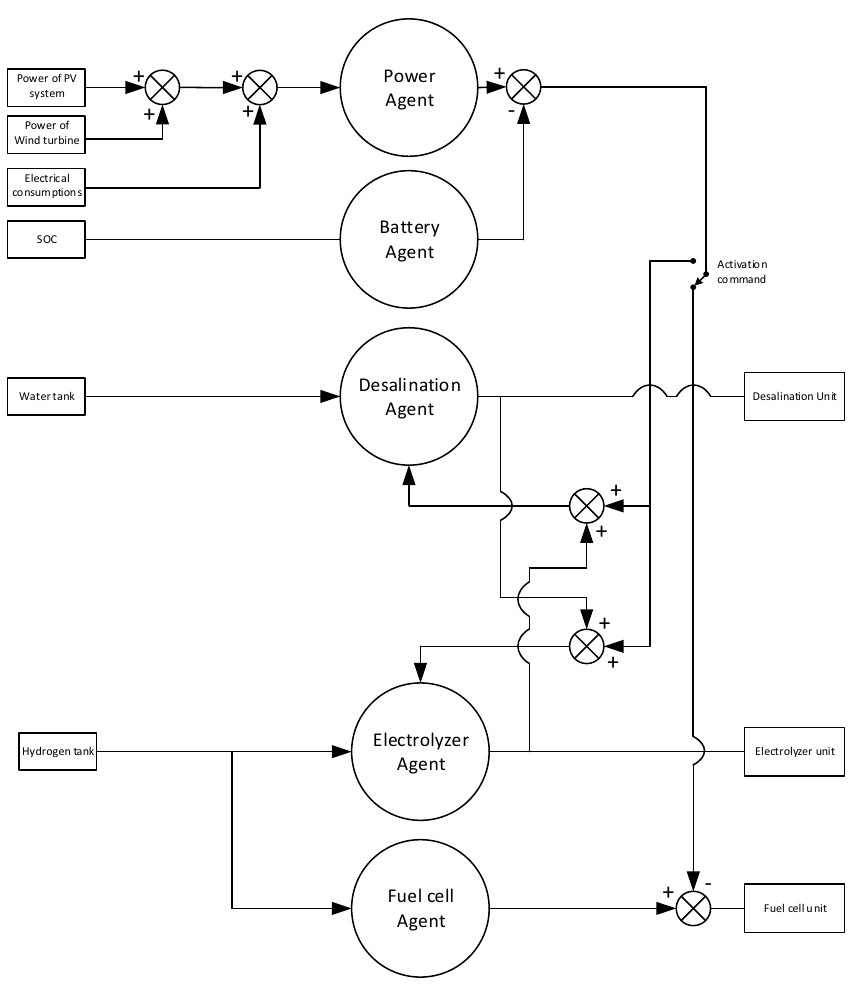
Figure 3. MAS-DEMS architecture.